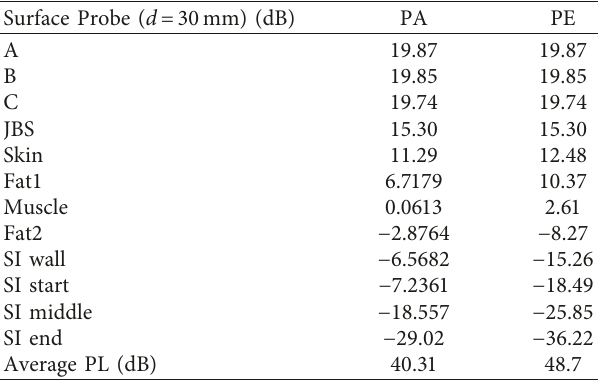
Table 9: Path loss values in dB at 4GHz using probes inside the multilayer model for d � 30 mm.